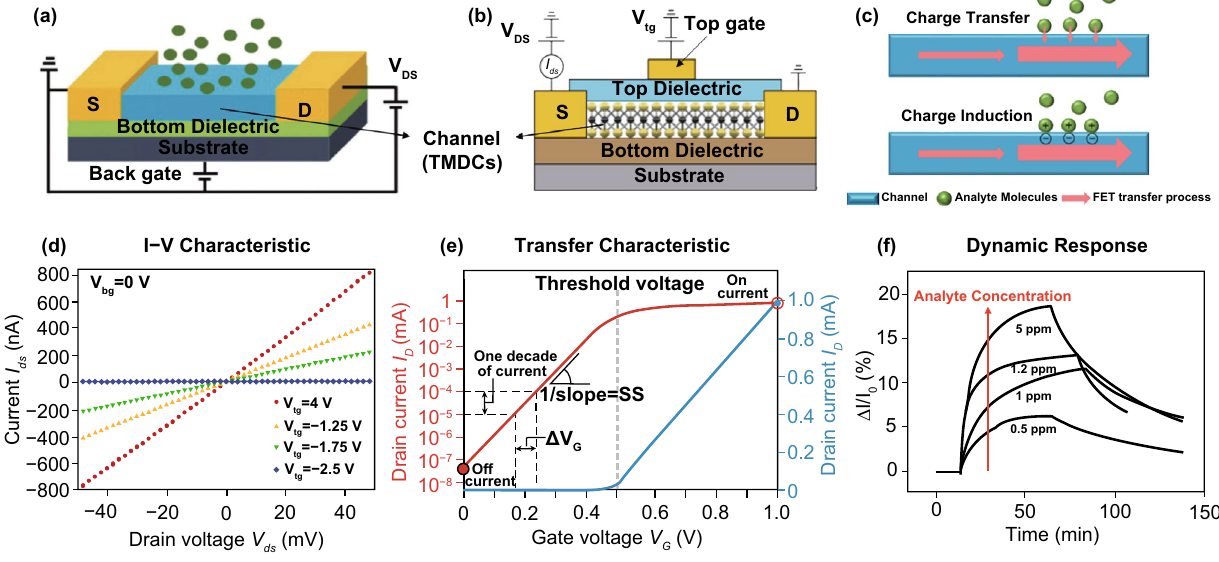
Fig. 2 Structure, working principle, electrical characterization, and sensing response of TMDC-based FET sensors. The structures of a back gate and b top gate FET with TMDC as the channel material. Reprinted with permission from Ref. [3], Copyright 2017, Royal Society of Chemistry. c General working principle of FET sensors: charge transfer through the interface of analyte and channel and the charge induction effect between analyte molecule and channel. d I – V characteristic ( I ds vs. V ds curve) of TMDC FET. Reprinted with permission from Ref. [11], Copyright 2011, Springer Nature. e Transfer characteristic is obtained by monitoring the drain current with a forward and backward sweep of gate potential. It offers critical parameters of FET device, including on/off ratio, threshold voltage, and subthreshold slope (ss). Reprinted with permission from Ref. [73], Copyright 2011, Springer Nature. f Sensing response is obtained by monitoring of the relative drain current change upon the target analyte, varied with the analyte concentration. Reprinted with permission from Ref. [83], Copyright 2012,